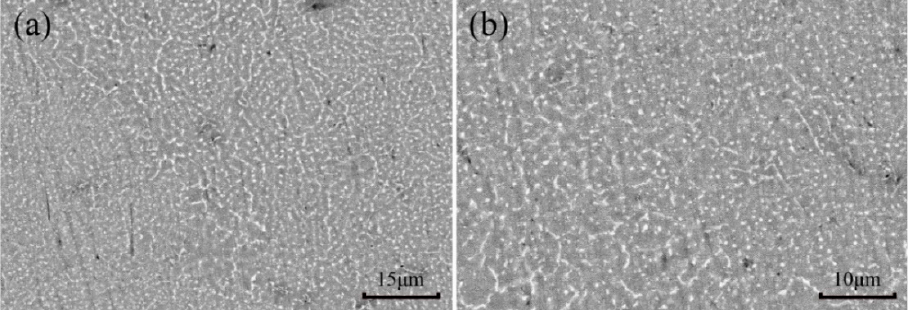
Figure 8. ( a , b ) SEM micrographs of AS41 sample at 80 J/mm 3